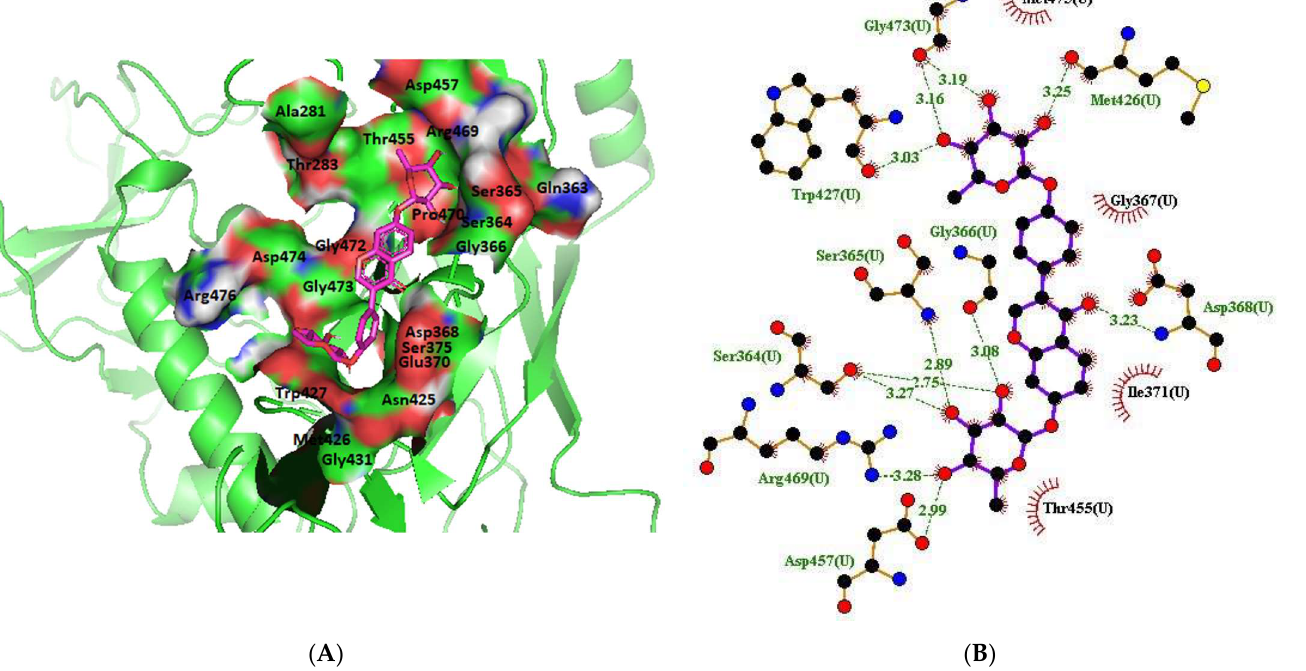
Figure 4. HIV gp120 of clade B-NP-005114 complex interaction profile. ( A ) Molecular representa- tion of HIV gp120 of clade B in complex with compound NP-005114 (represented as sticks, firmly docked into CD4-bs of HIV gp120). ( B ) Protein–ligand interaction profile of NP-005114 and clade B gp120. NP-005114 had eleven hydrogen bond interactions and four hydrophobic interactions with amino acids in the CD4-bs.